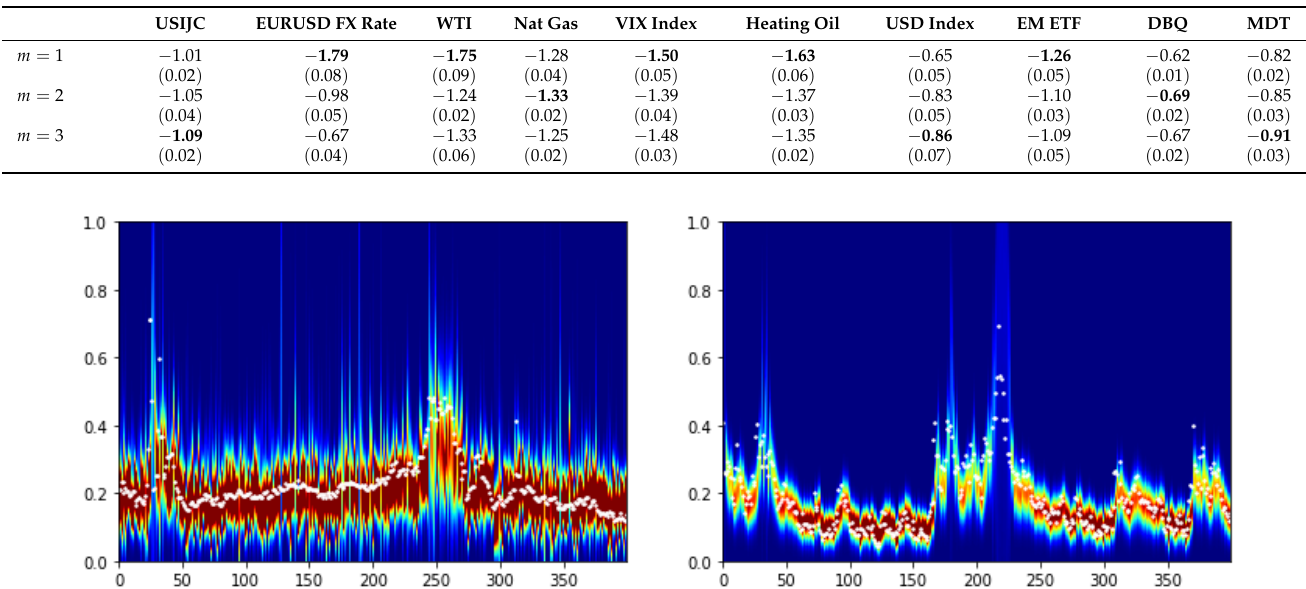
Table 4. Negative log-likelihood variation with m , with standard deviations in brackets.